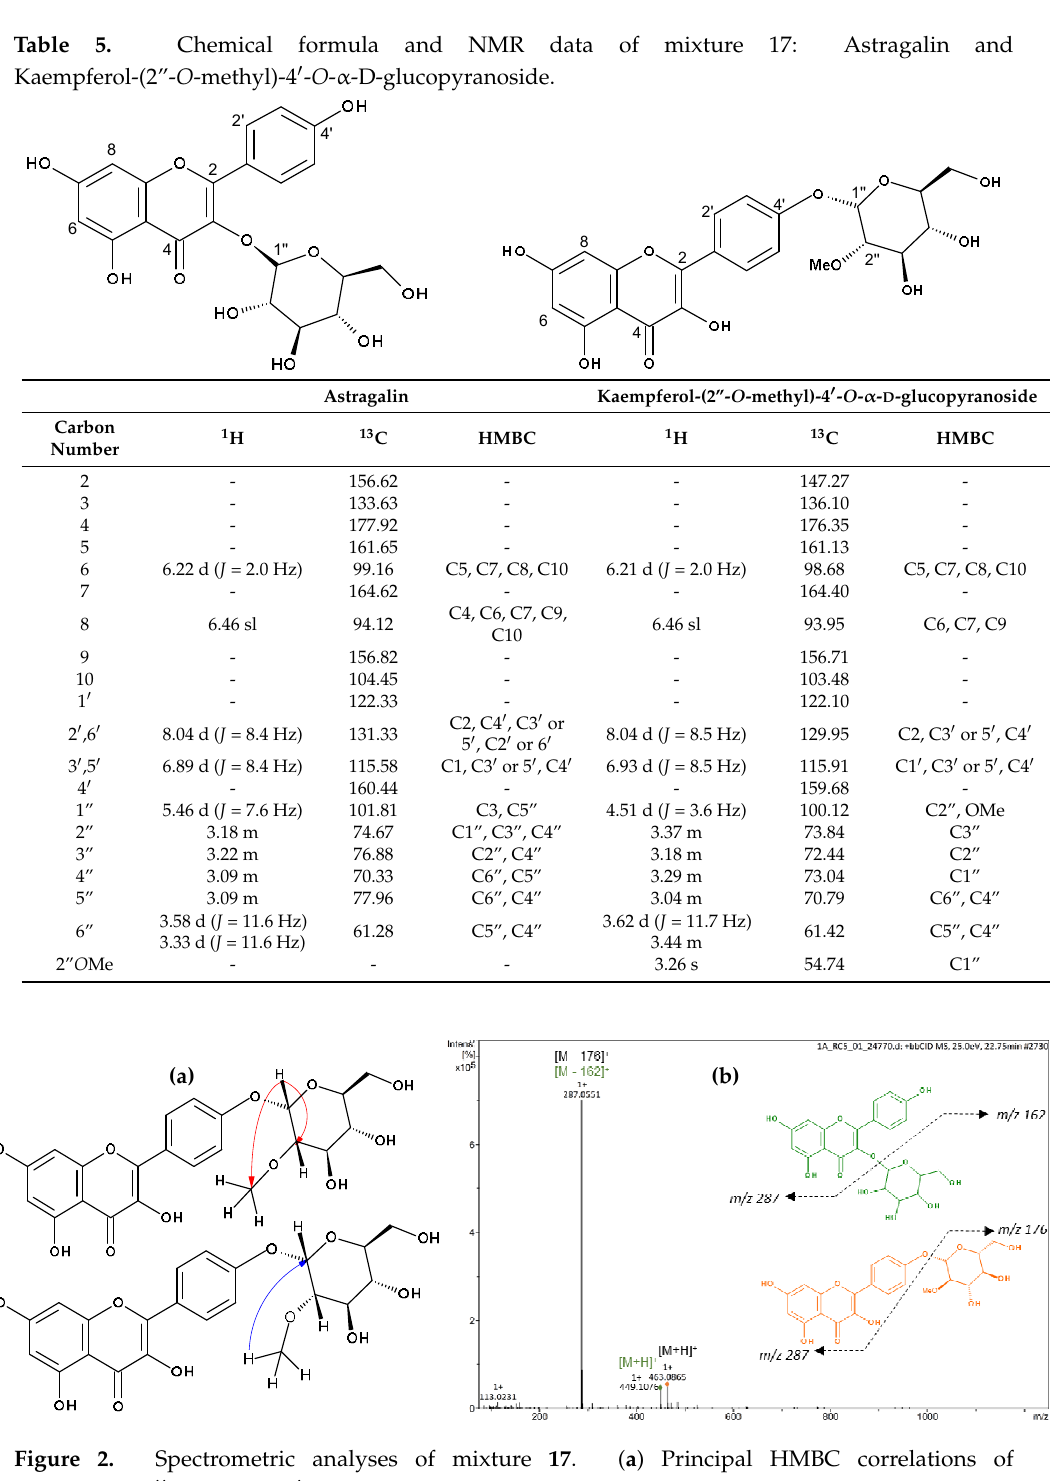
Figure 2. Spectrometric analyses of mixture 17 . (a) Principal HMBC correlations of kaempferol-(2′′- O -methyl)-4′- O -α- D -glucopyranoside . (b) Mass Spectrum and main fragmentation.